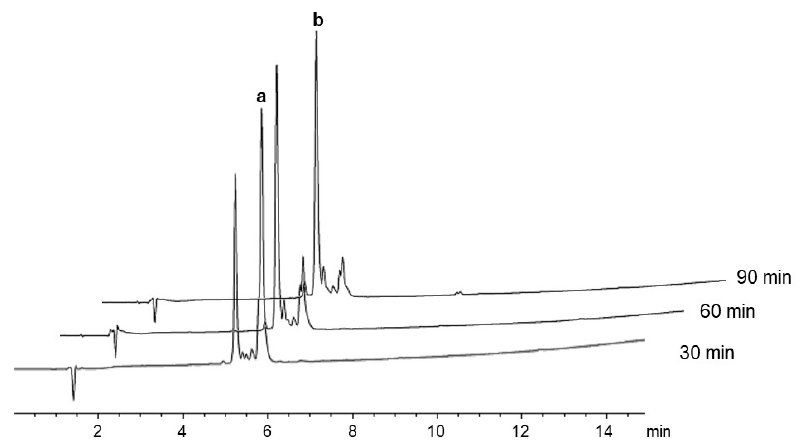
Figure 6. HPLC of the removal of the NO 2 groups from protected bradykinin-NH-Rink-amide-resin using 2 M SnCl 2 -0.04 M phenol-0.2 M aq HCl in 2-MeTHF at 55 °C (MW). a: protected peptide; b: unprotected peptide. Elution: 5–95% of B into A in 15 min.